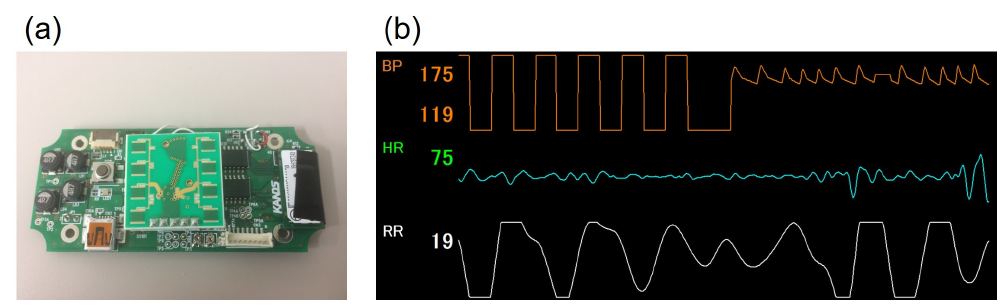
Figure 7. Prototype sensor that can measure blood pressure with ultrasonic sonar by Arakawa et al.: ( a ) the hardware system and ( b ) graphical user interface on measuring with this system, where the upper graph shows the time-series data of blood